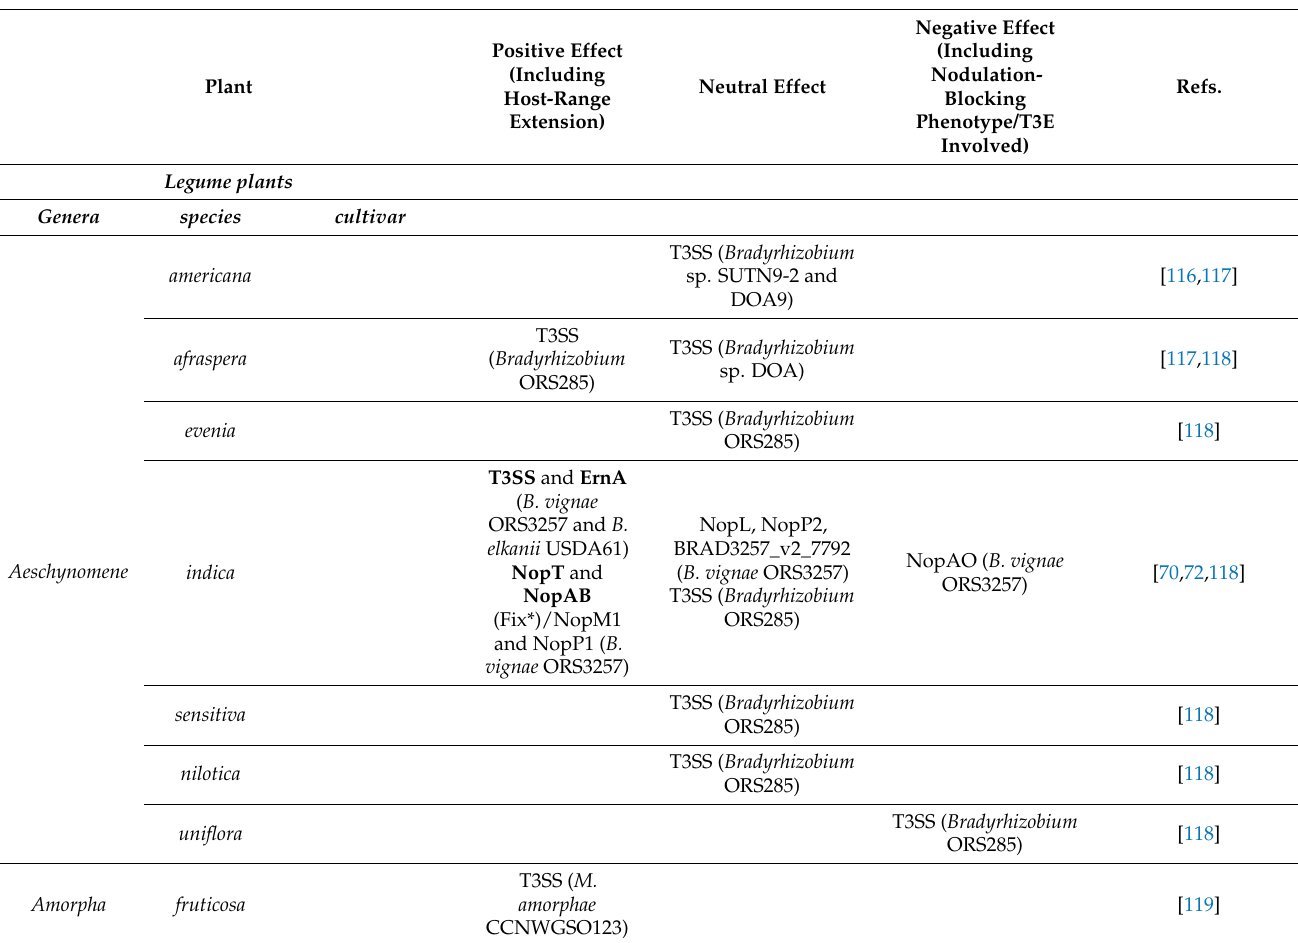
Table 2. Symbiotic phenotypes observed due to the presence of a functional T3SS or to secretion of T3SS effectors in different